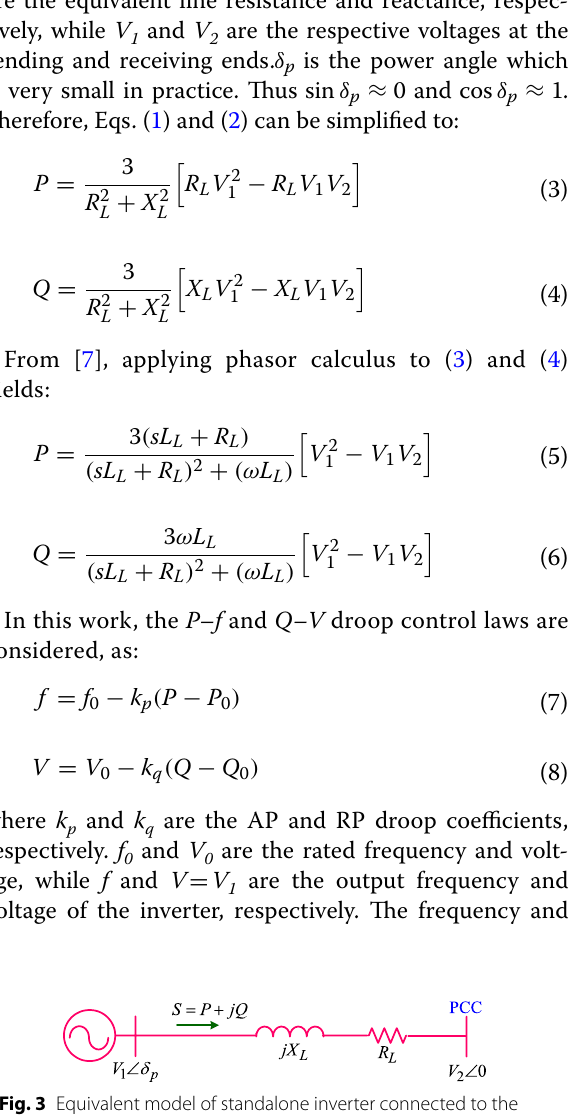
Fig. 2 Droop controlled inverter in standalone mode